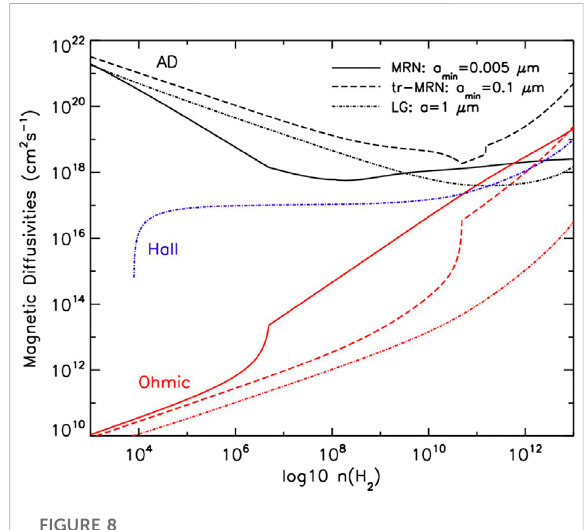
FIGURE 8 Change of MHD resistivities when removing the very small grains, from Zhao et al.